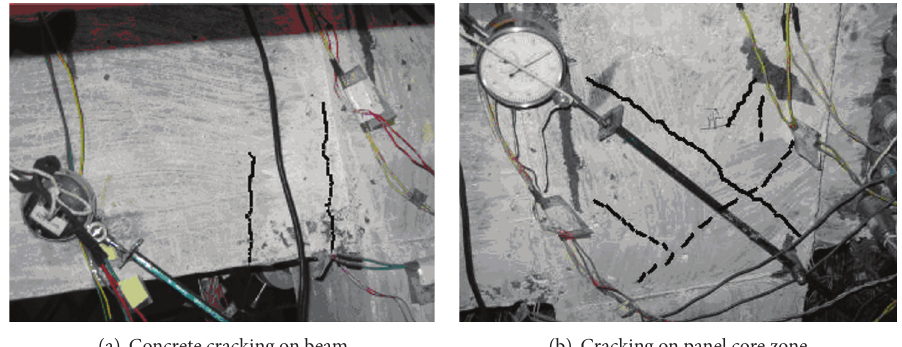
Figure 4: Experimental phenomenon in elastic stage.